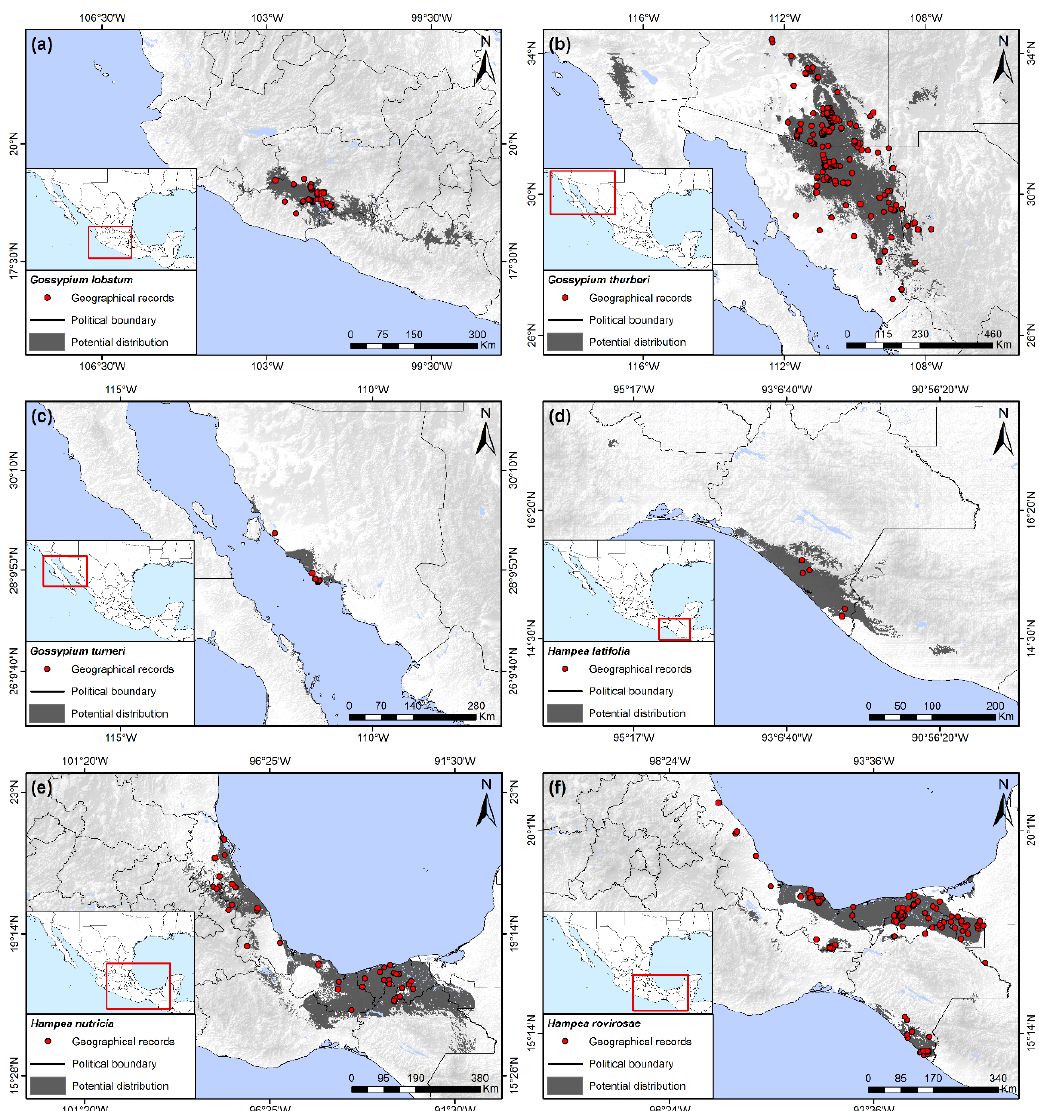
Figure 4. Potential distribution of wild host plants of the boll weevil. ( a ) Gossypium lobatum ; ( b ) Gossypium thurberi ; ( c ) Gossypium turneri ; ( d ) Hampea latifolia ; ( e ) Hampea nutricia ; ( f ) Hampea rovirosae .